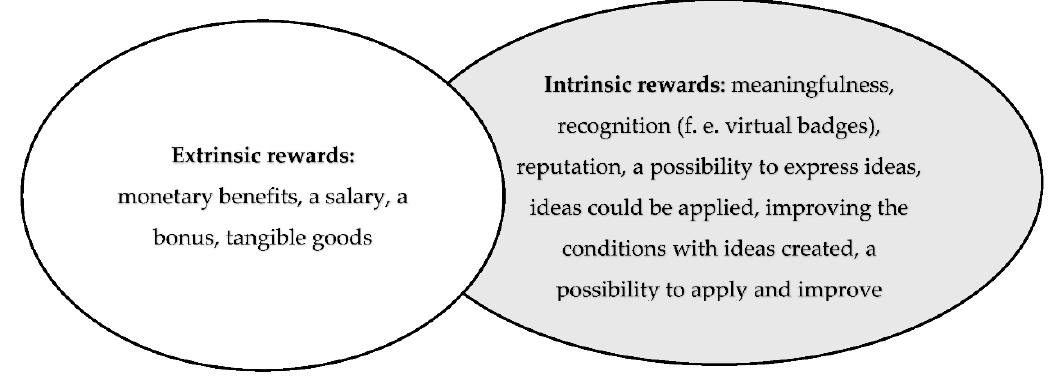
Figure 10. Extrinsic and Intrinsic rewards in IMS.